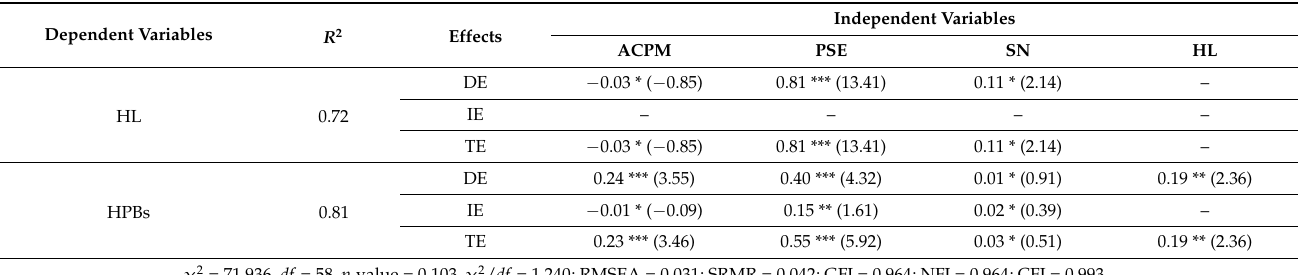
Table 3. The direct, indirect, and total effects among the variables in the